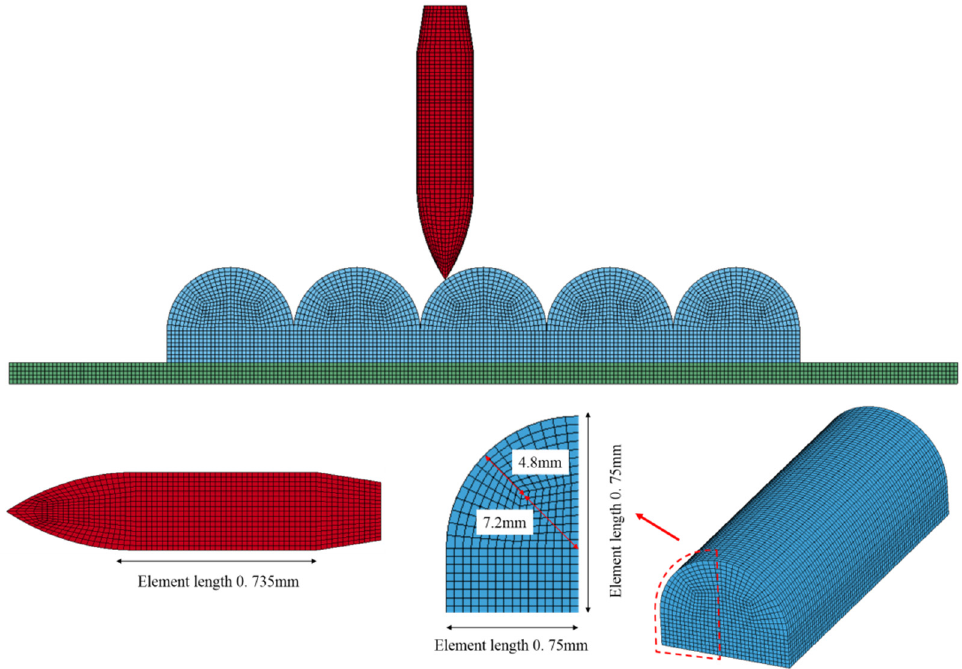
Figure 5. Finite element model.